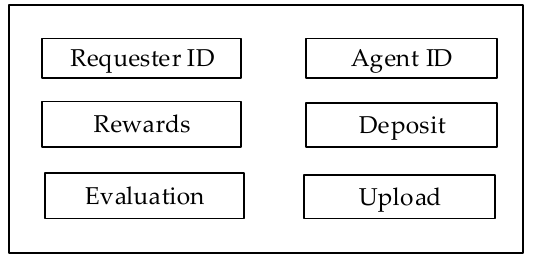
Figure 4. The components of smart contract.